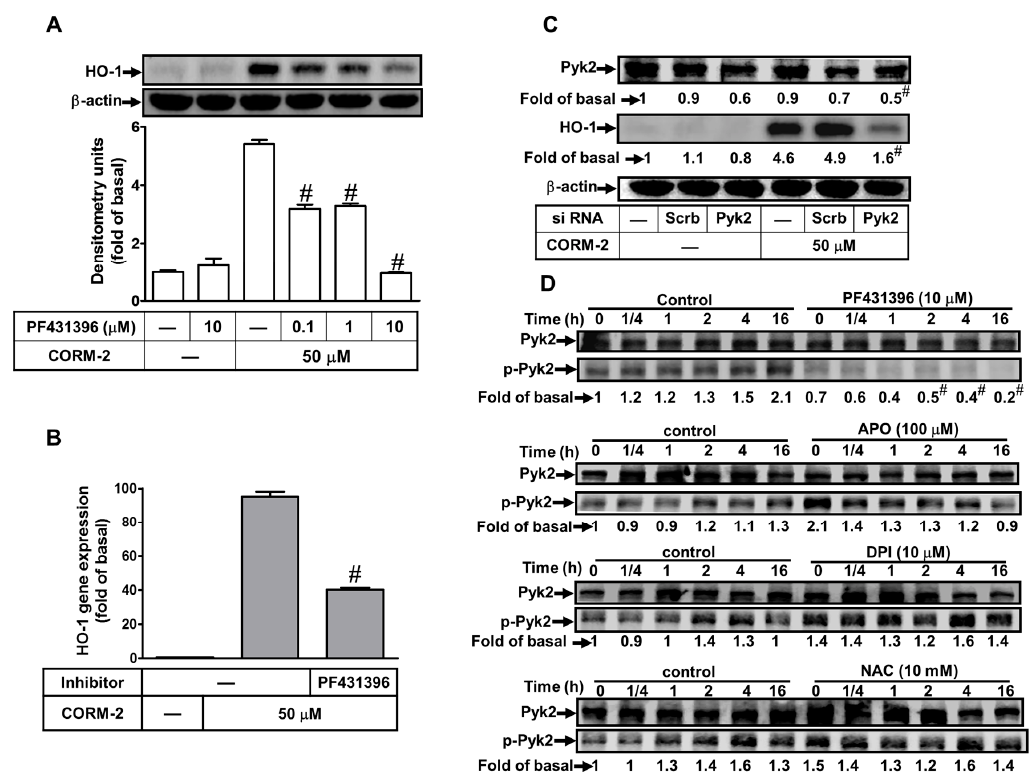
Figure 5. Proline-rich tyrosine kinase 2 (Pyk2) is involved in CORM-2-induced HO-1 expression in HTSMCs. ( A ) Cells were pretreated with PF431396 for 1 h, and then incubated with CORM-2 for 24 h. The protein levels of HO-1 and β -actin (served as an internal control) were determined by western blot. ( B ) Cells were pretreated with PF431396 (10 µ M) for 1 h, and then incubated with CORM-2 for 6 h. The mRNA expression of HO-1 was determined by real-time PCR. ( C ) Cells were transfected with either scrambled (Scrb) or Pyk2 siRNA, and then incubated with CORM-2 for 24 h. The levels of Pyk2, HO-1, and β -actin (served as an internal control) protein were determined by Western blot. ( D ) Cells were pretreated without or with PF431396 (10 µ M), APO (100 µ M), DPI (10 µ M), or NAC (10 mM) for 1 h, and then incubated with CORM-2 for the indicated time intervals. The levels of phospho-Pyk2 and Pyk2 (served as an internal control) were determined by Western blot. Data are expressed as mean ± SEM of five independent experiments ( n = 5). # p < 0.05, as compared with the cells exposed to CORM-2 alone. Data analysis and processing are described in the section “Statistical Analysis of